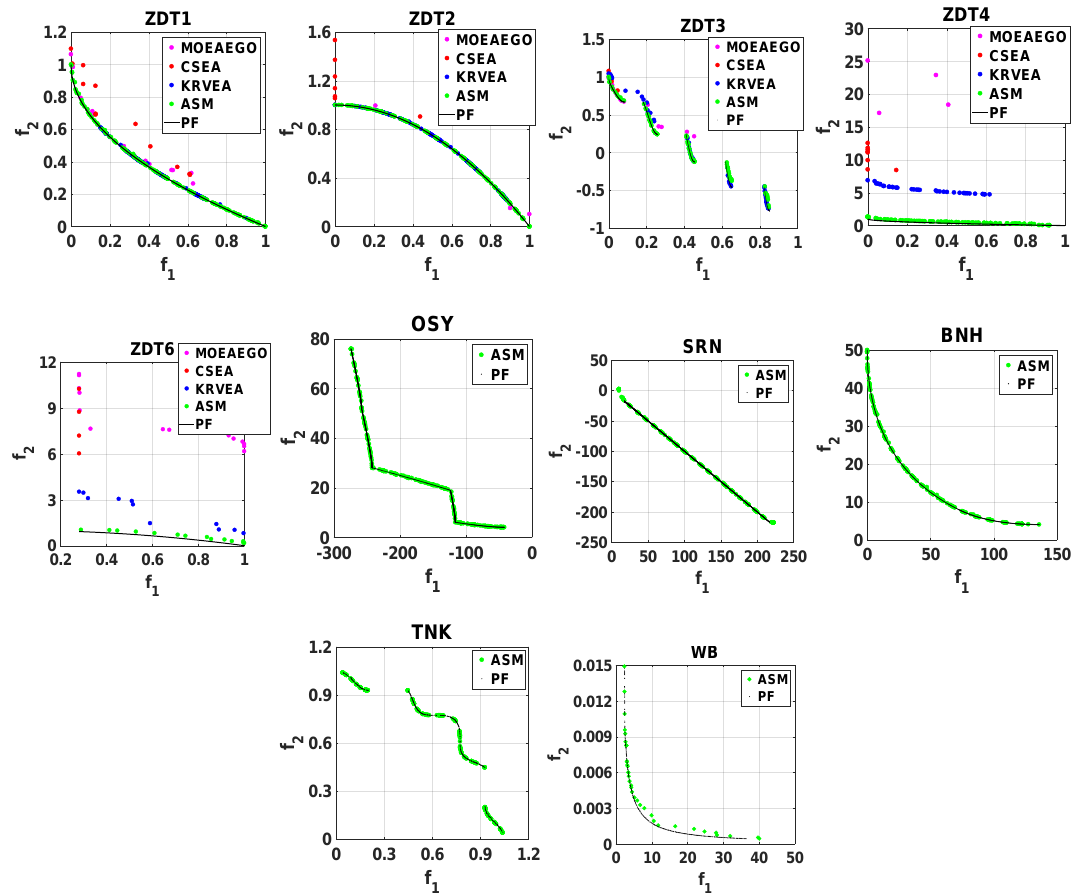
Figure 7. Non-dominated solutions of the final archive for the median run of ASM approach for two-objective ZDT and constrained problems. In all cases, a well-diversified set of near PO solutions is obtained with a limited solution